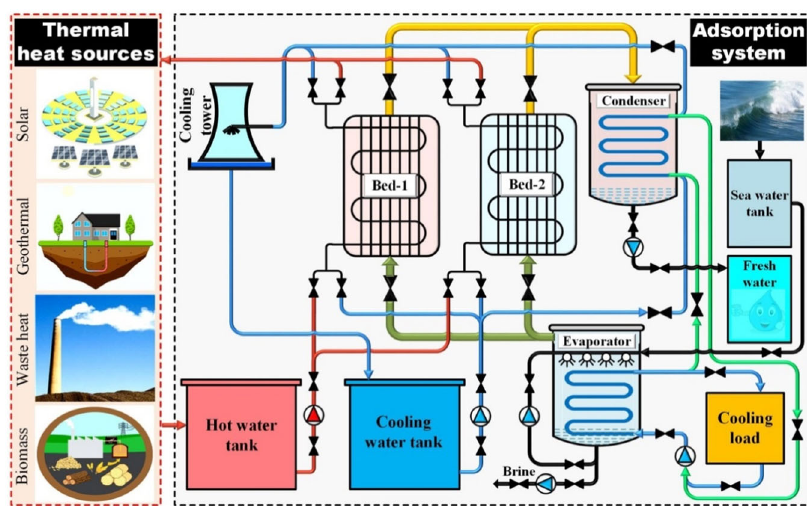
Fig. 1 Adsorption system for cooling and desalinationapplications with different thermal heat sources. The system consists of 2 beds, a condenser, and an evaporator, in addition to the complementary parts such as the cooling tower, cooling, heating and desalinated water tanks, water fl ow pumps and valves. The green lines are the heat transfer lines by water fl ow from the evaporator to the condenser and